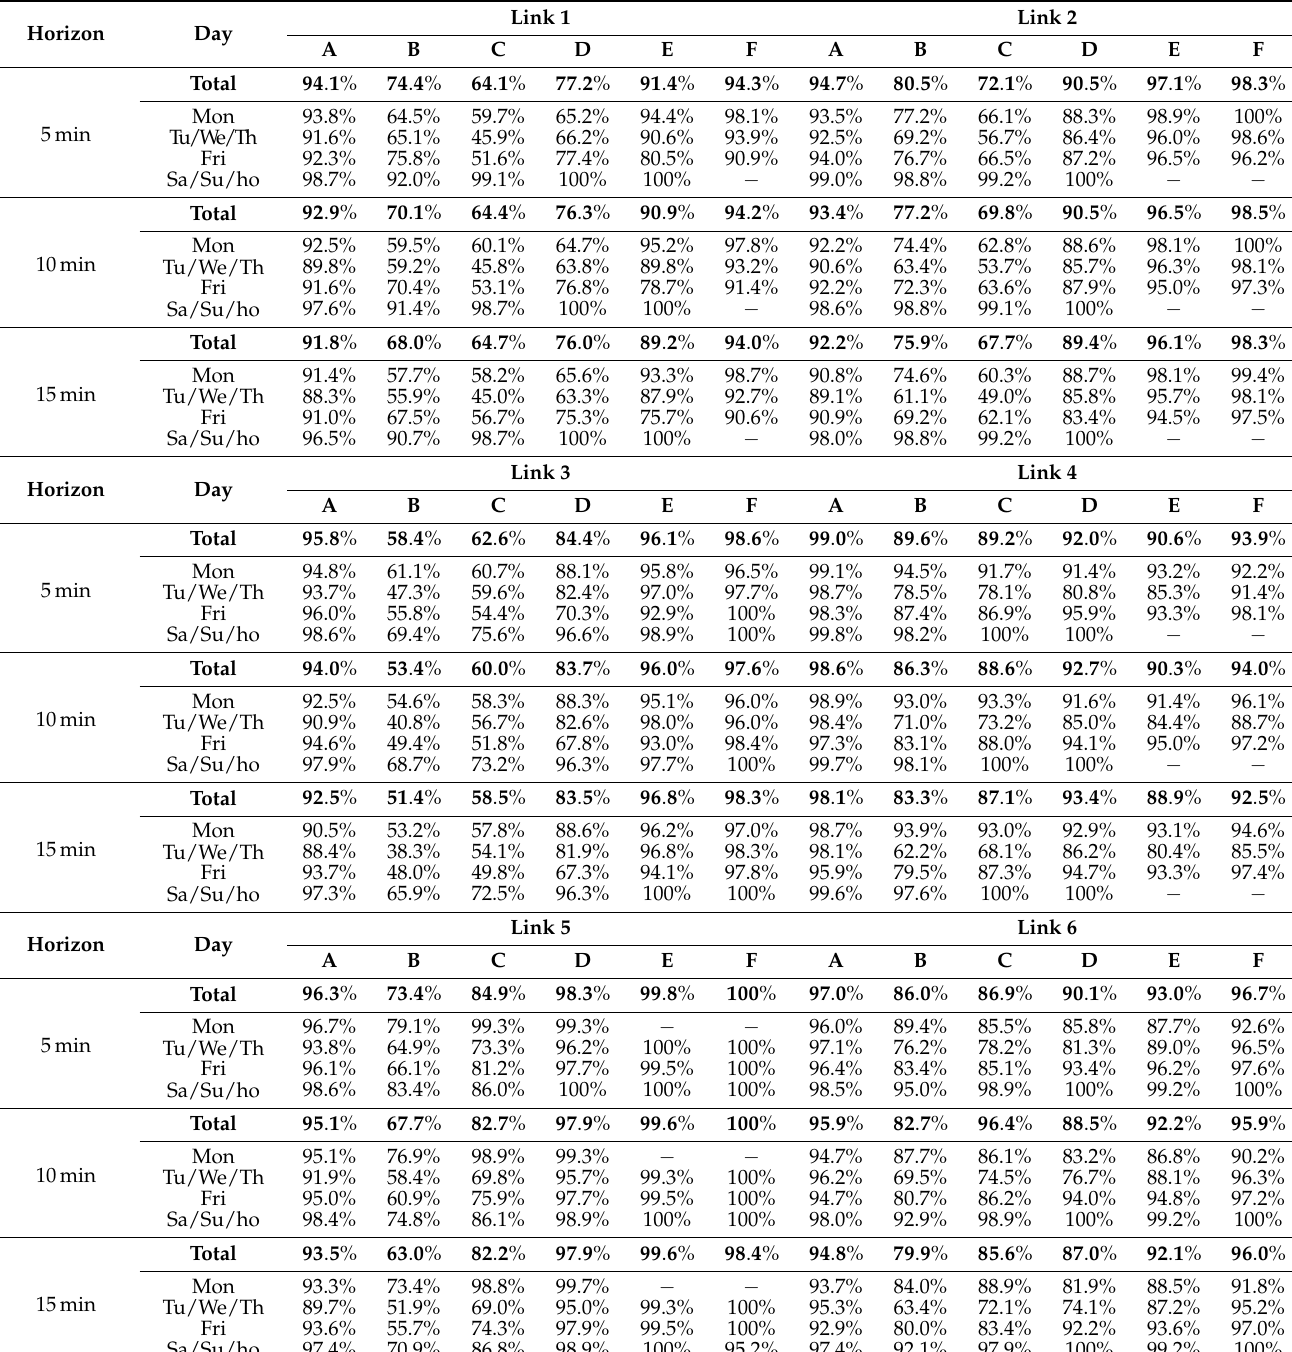
Table 2. Detailed performance